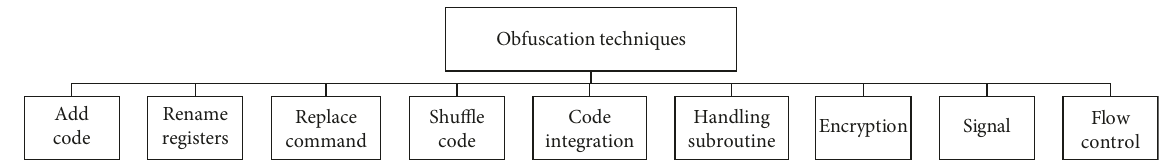
Figure 1: Different approaches for